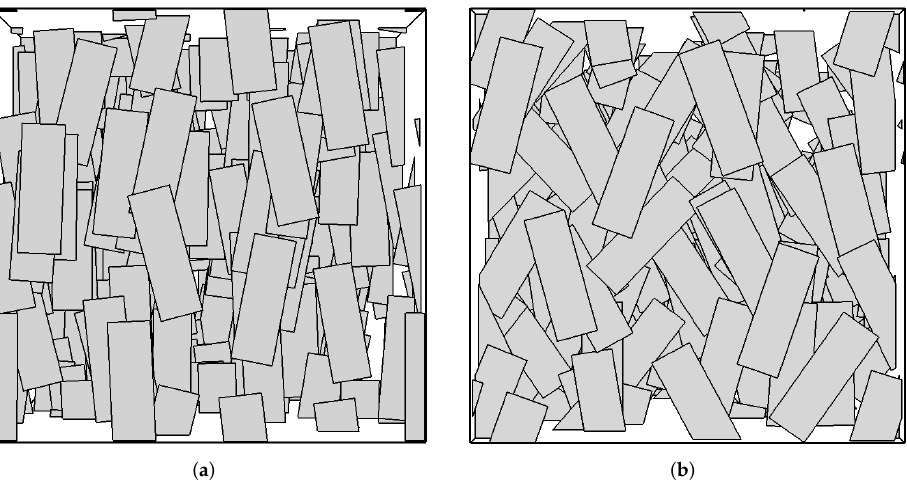
Figure 1. Top view of sample geometries showing flakes oriented at different intervals [ − (cid:101) , + (cid:101) ] around the y-axis. ( a ) (cid:101) = 15 ◦ , ( b ) (cid:101) = 45 ◦ . In both images the aspect ratio r = 3. For visual clarity, only a few flakes are shown. In the sectioning experiments used to validate the results of this work, each composite contained up to 10 6 individual